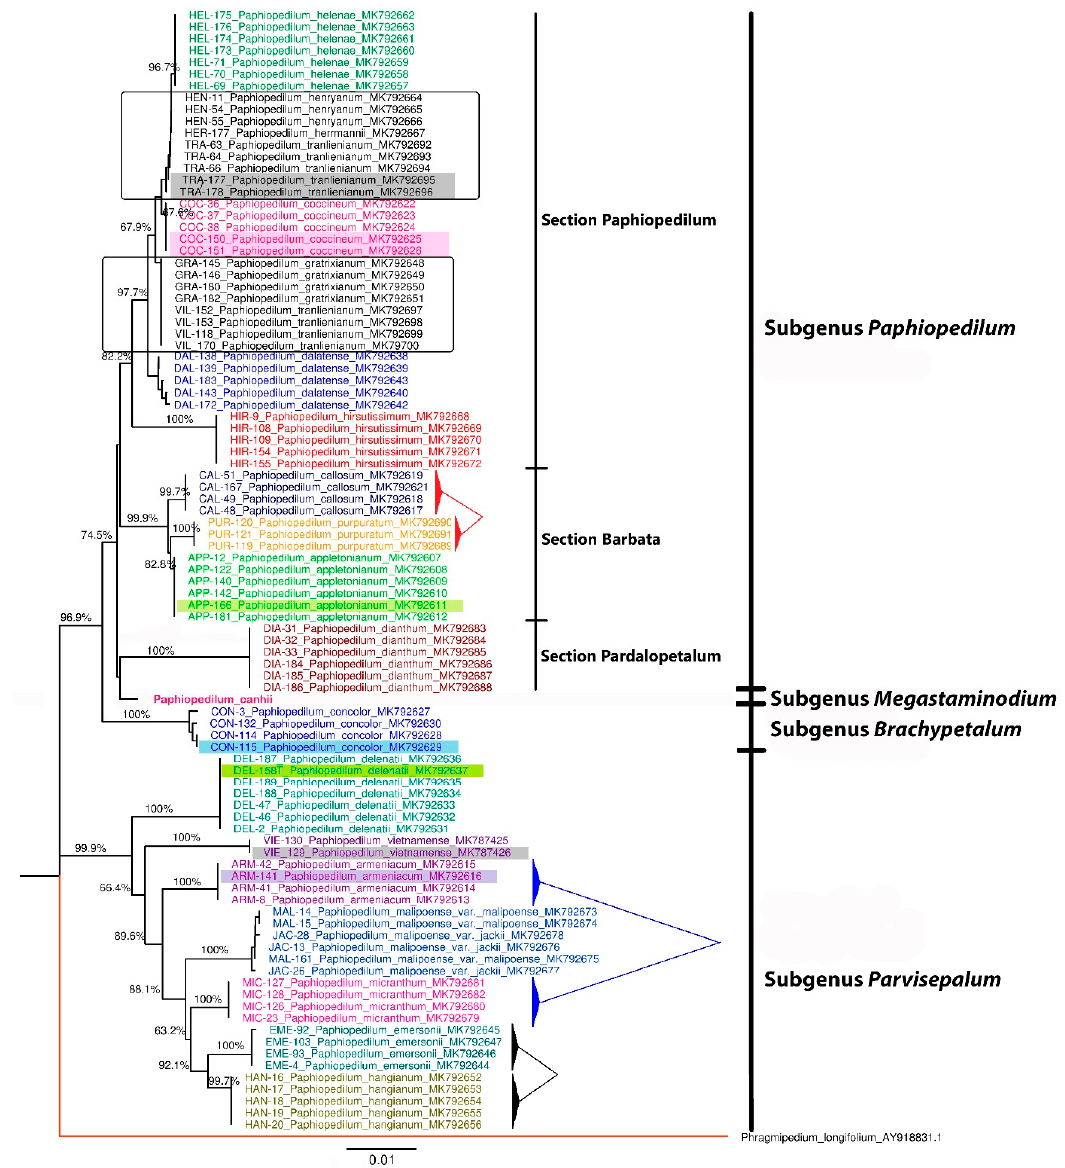
Figure 3. Phylogenetic tree of 22 Vietnamese Paphiopedilum species based on mat K + ITS barcode using the neighbor-joining method in the MEGA software. (Specimen voucher is before the scientific name, GenBank accession number is after the scientific name. Phragmipedium longifolium is the outgroup species. Five species in rectangular boxes and written in black are unidentified, the colored ones represent 17 identified species. Samples collected from trading markets were filled with highlighted colors. Three pairs of species, i.e., P. emersonii versus P. hangianum , P. micranthum versus P. armeniacum , P. callosum versus P. purpuratum , comprised leaf morphological similarity in pairs). As no specimen of Paphiopedilum canhii species could be collected, we tried to collect its sequences from the reference GanBank for overall analysis. Two accessions of ITS and mat K were selected (shown in Table S2). No trn L accession was submitted. On the ITS + matK tree, P. canhii was located on a distinguished branch, and was quite far from its closest neighbor, P. dianthum . Due to this difference, P. canhii was classified in a new subgenus, Megastaminodium (Figure 3). In total, 17 out of the 22 species of the Vietnamese Paphiopedilum population, i.e., P. helenae , P. coccineum , P. dalatense ,